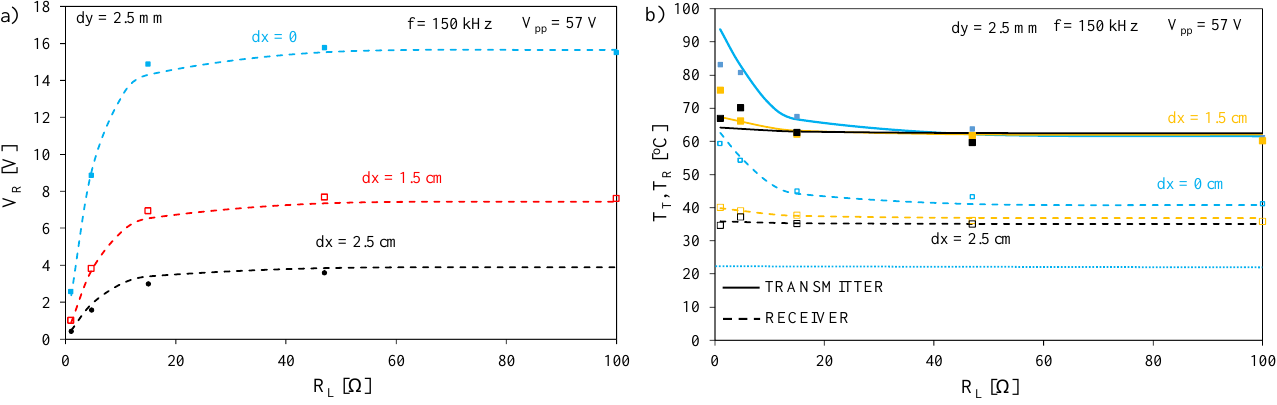
Figure 14. Dependence of voltage on the receiving coil ( a ) and temperatures of both the coils ( b ) on load resistance at selected values of the distance dx between the axes of these coils.